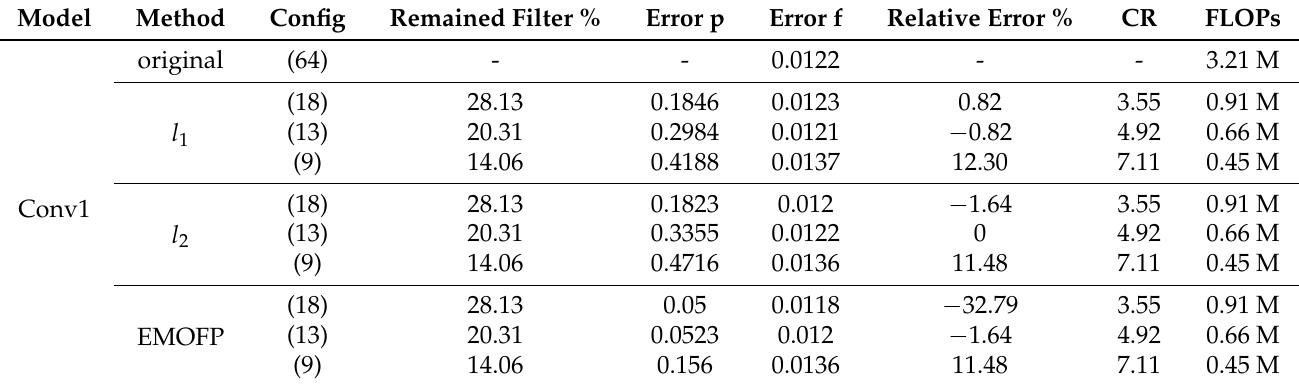
Figure 3. Pareto fronts of EMFP and scatter plots of fine-tuned solutions on designed models. Subfigure ( a – d ) mean the scatter plots on Conv1, Conv2, Conv3 and Conv4, respectively. Table 3. Pruning results of Conv1 on MNIST. Error p and Error f mean the error of the pruned model before fine-tuning and the fine-tuned model, respectively. CR means the filter compression ratio of the pruned